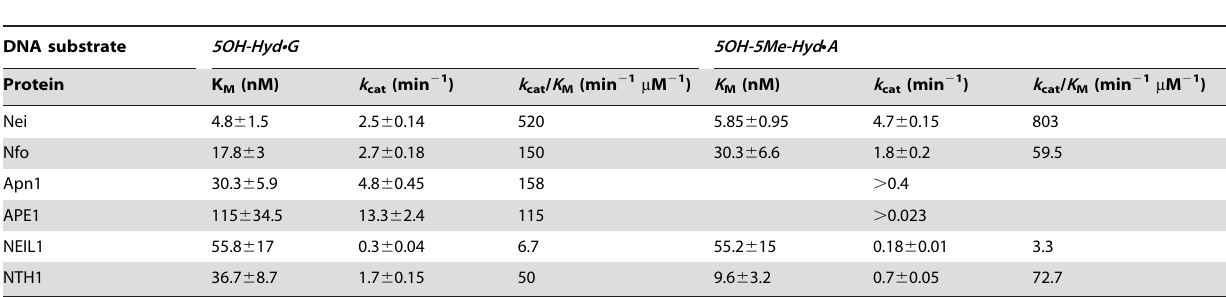
Table 1. Steady-state kinetic parameters of the AP endonucleases and DNA glycosylases activities on hydantoin residues when present in duplex